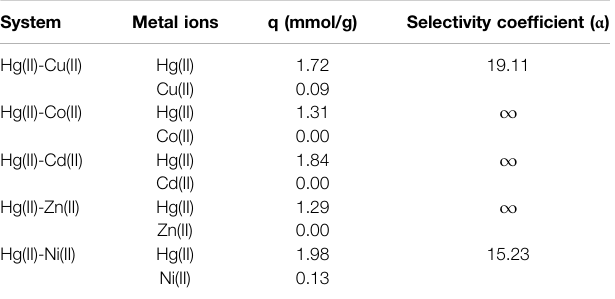
TABLE 7 | Adsorption selectivity of HPAMAM-ECH -3 toward Hg(II) at pH 5.0, 25 ° C. System Metal ions q (mmol/g) Selectivity coef fi cient ( α